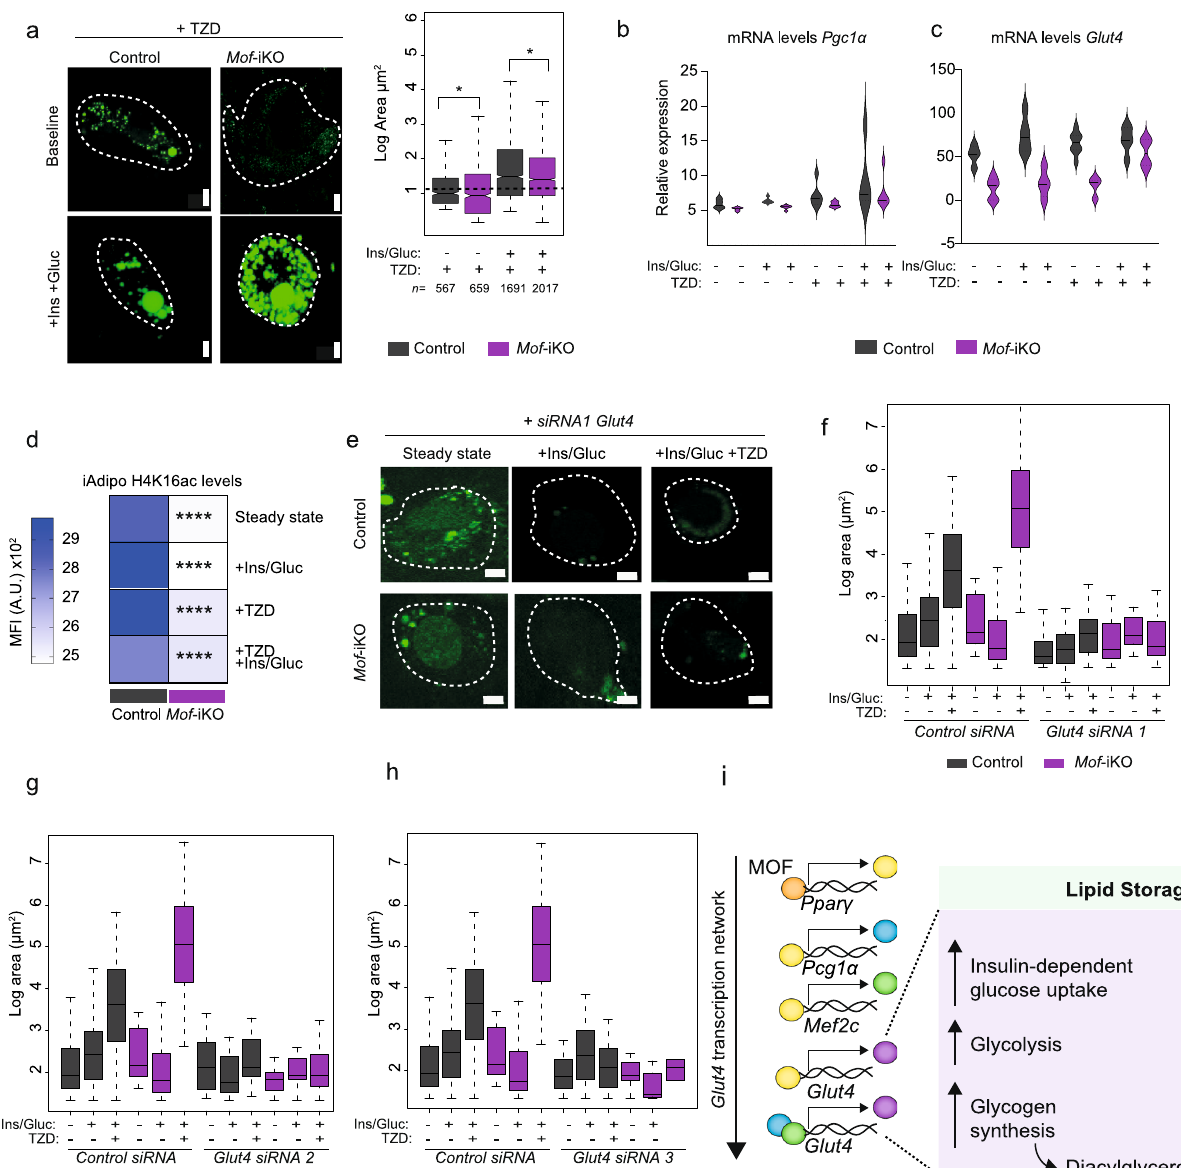
Fig. 7 PPAR γ agonists can rescue lipid storage in Mof-iKO adipocytes only in the presence of Glut4 . a Left: representative images of neutral lipid staining (BODIPY-493; green). Control or Mof -iAdipo treated with thiazolidinedione (TZD)(10 − 4 mol/L) at baseline (upper panel) or upon insulin/glucose challenge (bottom panel). Scale bar: 5 µ m. Right: boxplot showing quanti fi cation of overall lipid droplet area per droplet ( µ m 2 ) in logarithmic scale with boxes showing the interquartile range. Number of biological replicates per condition: n = 3. Total number of droplets used for quanti fi cation are indicated on the fi gure. Dashed horizontal lines mark the mean area of controls. Statistical analysis was performed using the raw data and one-way ANOVA followed by Kruskal – Wallis comparison test, * p = 0.039. b , c RT-qPCR analyses of control or Mof -iAdipo cells treated with TZD at baseline or upon insulin/glucose challenge. Violin plots show the average Pgc1 α ( b ) and Glut4 ( c ) mRNA expression of biological replicates ( n = 3). Dotted lines show the quartiles and solid lines depict the medians. d Heatmap showing H4K16ac levels after TZD treatment at different conditions. Statistical analysis was performed using the raw data and two-sided two-way ANOVA followed by Sidak multiple comparison post test, **** p = 10 − 16 . e Representative images of neutral lipid staining (BODIPY-493; green). Control or Mof -iAdipo treated with Glut4 siRNA in the presence or absence of thiazolidinedione (TZD)(10 − 4 mol/L) at baseline or upon insulin/glucose challenge ( + Ins/Gluc). Scale bar: 5 µ m. f – h Boxplots showing quanti fi cation of overall lipid droplet area per droplet ( µ m 2 ) in logarithmic scale. Dashed horizontal lines mark the mean area of controls. Number of biological replicates per condition: n = 3. The “ Control siRNA ” data is identical in ( f ), ( g ) and ( h ). ( i ) Schematic representation of proposed MOF-mediated regulation of the Glut4 transcription network. See also: Supplementary Fig. amino acid metabolism and adipose tissue homeostasis. Our important biomarker to predict future risk of developing meta- fi ndings have important clinical implications for understanding bolic syndromes. We envision that advances in cell-type-speci fi c the contribution of epigenetic regulators to metabolic disorders delivery of small molecule inhibitors aimed at modulating acet- such as obesity, cardiovascular disorders, and T2D as well as ylation levels could be an exciting avenue for future research in cancer. Importantly, alterations in MOF levels can serve as an the battle against obesity and its comorbidities.